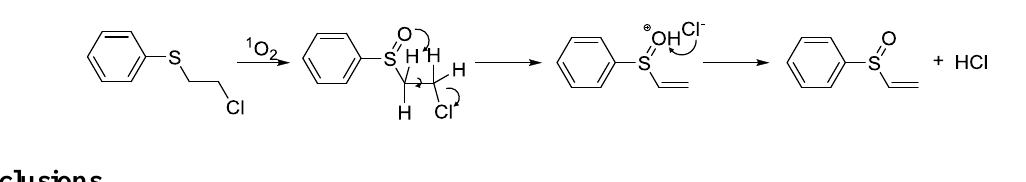
Figure 12. Potential pathway of sulfide oxidation followed by dehydrohalogenation of